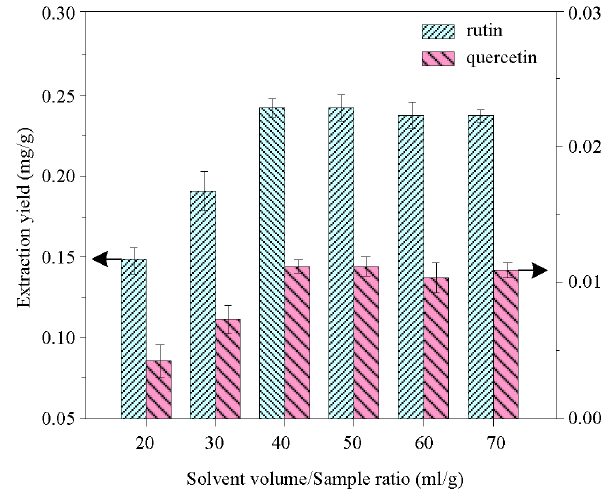
Figure 4. Effect of solvent volume/sample ratio using 60% concentration of ethanol solution with 80 kHz at 30 °C and 200 W for 30 min on the extraction of quercetin and rutin.